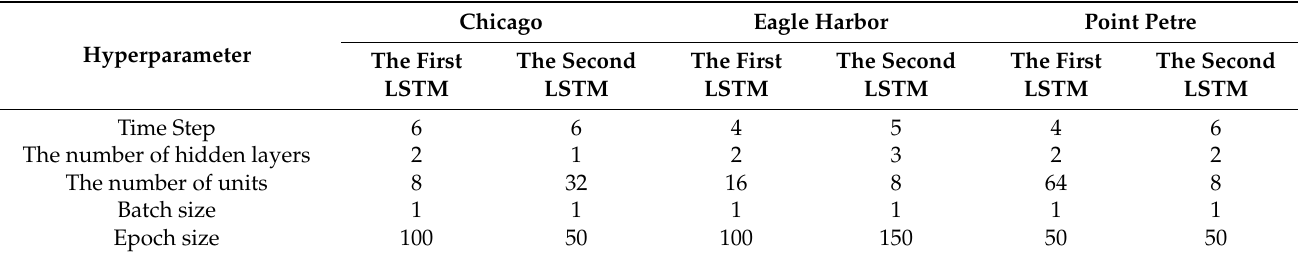
Table 5. Optimal hyperparameter combination of our system on three